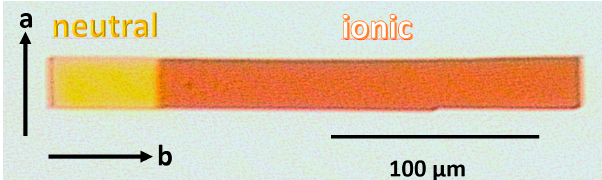
Figure 1. Snapshot of the coexistence of N and I state at T NI manifested in tetrathiafulvalene- p -chloranil (TTF-CA) by color changes. Adapted with permission from Reference [6]. Copyright 2003 American Physical Society.